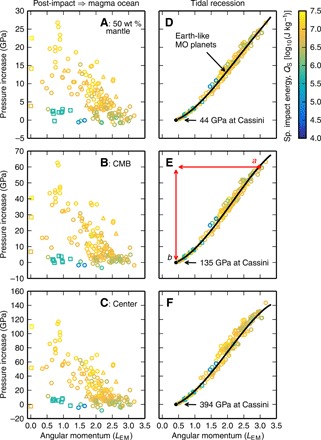
Pressures in the interior of Earth-mass bodies change substantially during cooling and tidal evolution.The change upon condensation of the post-impact vapor, i.e., the difference in pressure between the post-impact state (Fig. 2, A to C) and the magma ocean planet (Fig. 2, D to F), varies substantially between different impacts (A to C). The decrease in the AM of Earth during lunar tidal recession could have substantially increased the internal pressures in the planet. (D to F) Demonstration of the increase in internal pressures upon tidal recession of the Moon to the Cassini state transition for a body with a given initial AM. Assuming that the AM of the Earth-Moon system had reached its present-day value, the AM of Earth at the Cassini state transition (a lunar semi-major axis of about 30 Earth radii) was 0.417 LEM. The black line shows the pressure increase for an Earth-like body. Symbols and colors are the same as in Fig. 2. Paths and points in (E) are discussed in the main text.